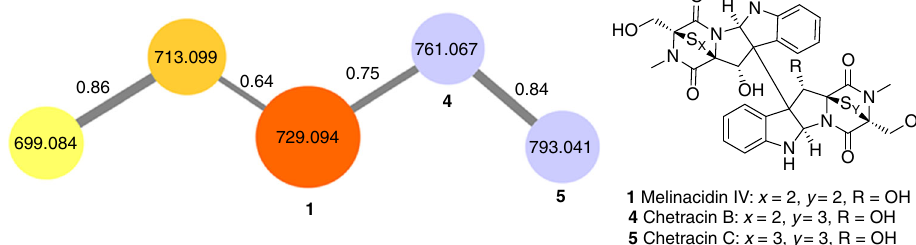
Fig. 4 Molecular network and chemical structures of ETPs being produced by Escovopsis strains A –